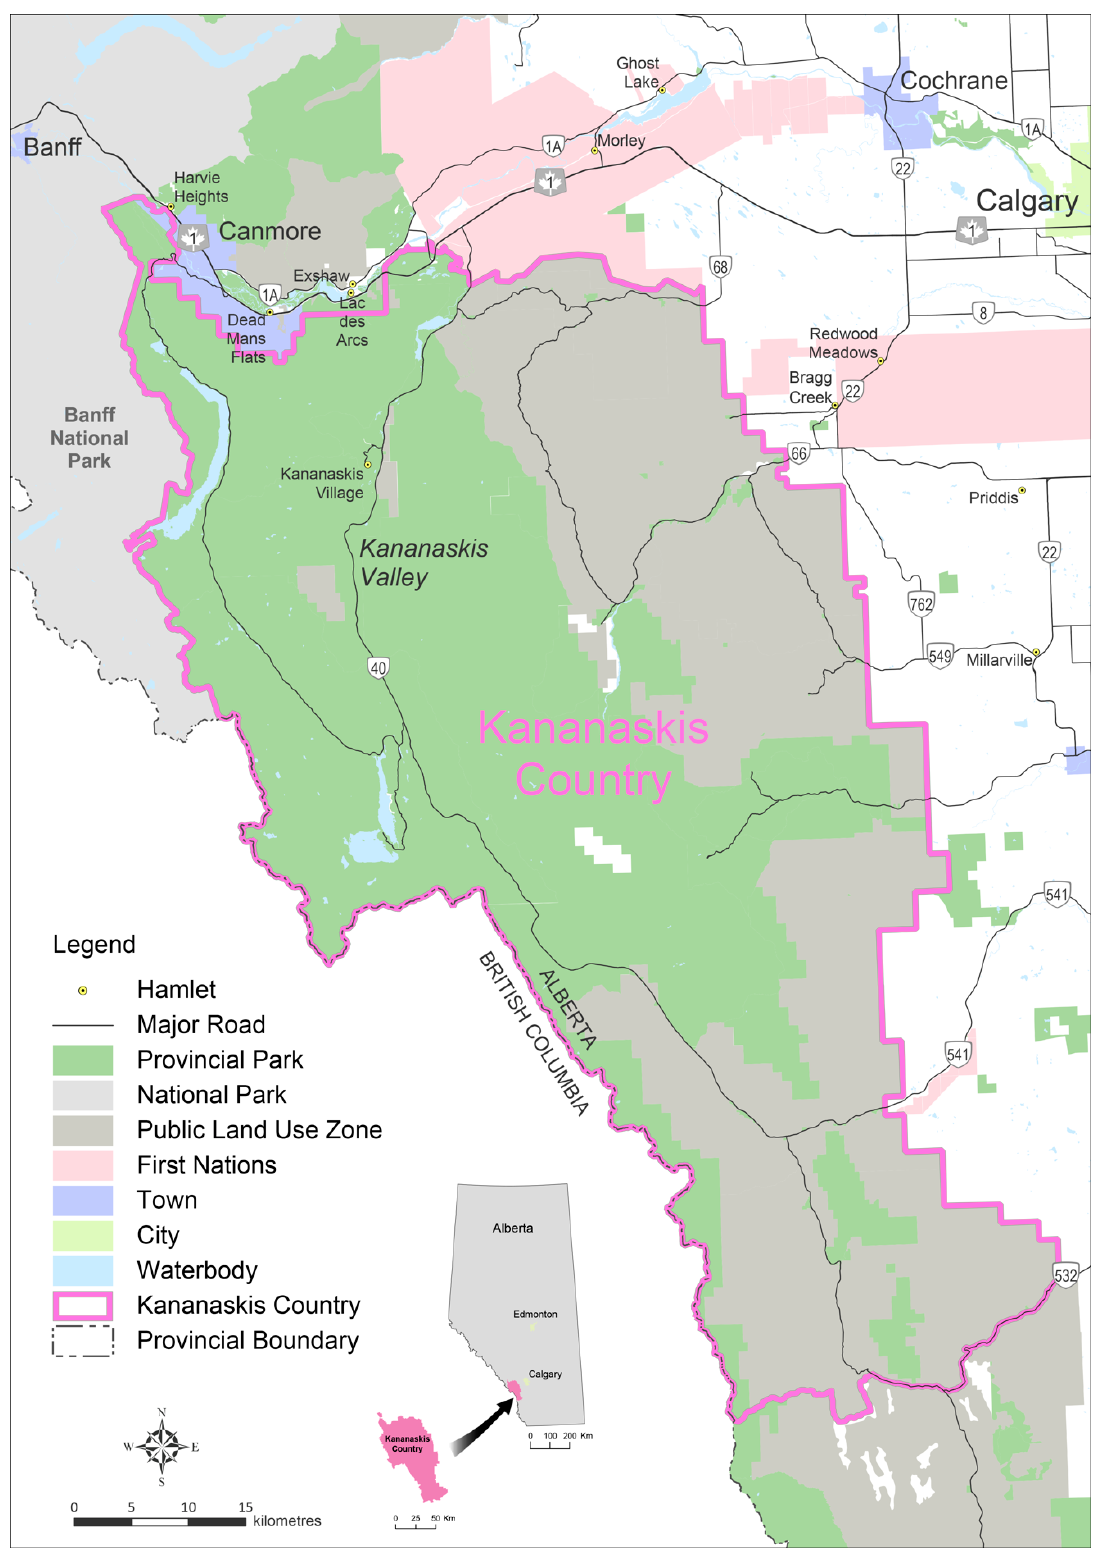
Figure 1. Map of Kananaskis Valley.